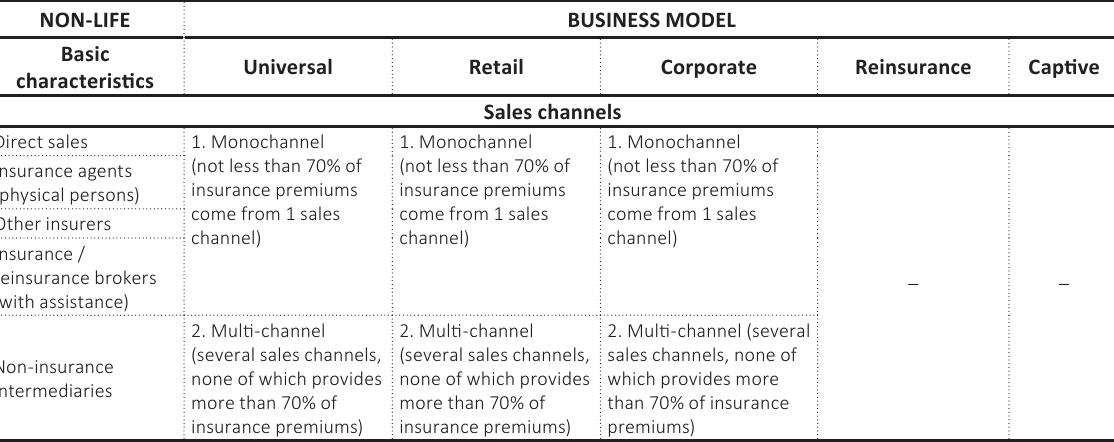
Table 5 (cont.). Business model of NON-LIFE insurance companies according to the National Bank